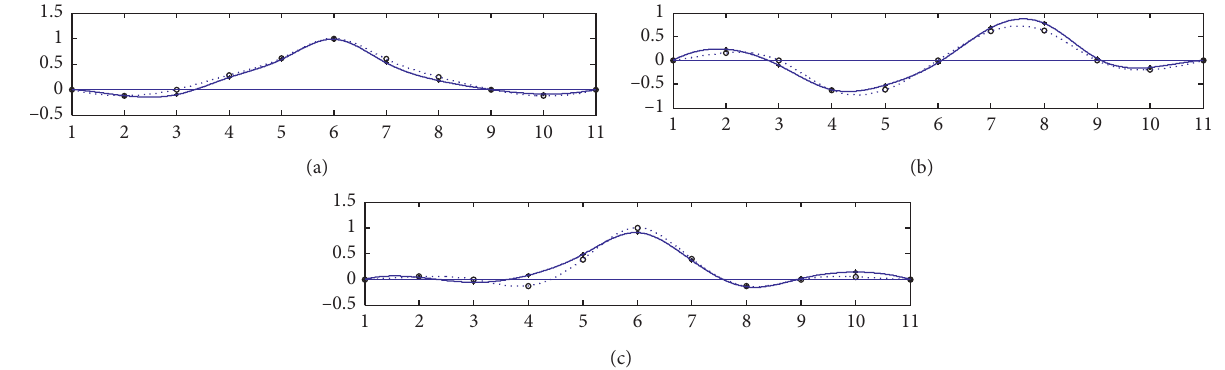
Figure 13: Modal shape of the first three orders. (a) Vibration diagram of the first order. (b) Vibration diagram of the second order. (c) Vibration diagram of the third